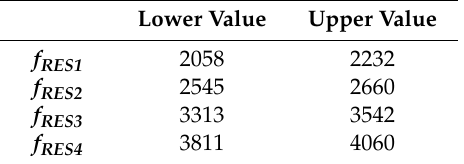
Table 2. Range of values for each resonance frequency (MHz).